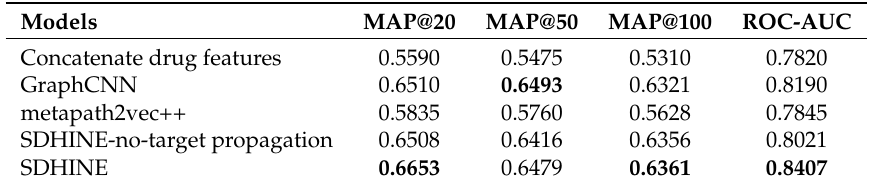
Table 4. Side effect identification performance comparison.